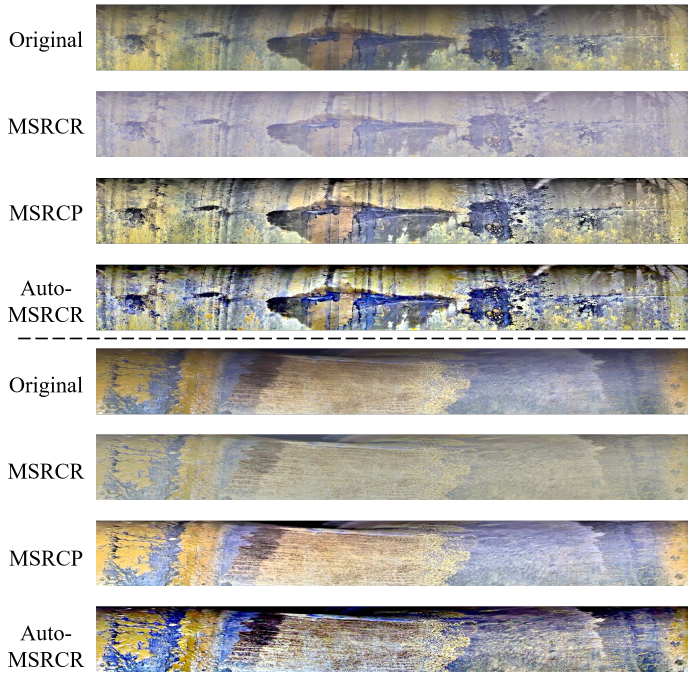
Figure 8. Comparison of the effects of different image enhancement methods.